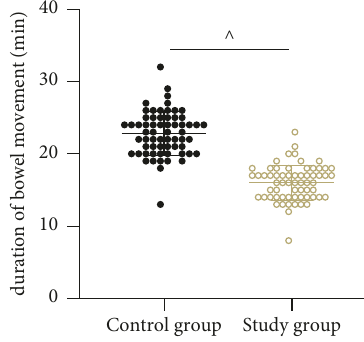
Figure 7: Comparison of care satisfaction scores within the two groups (scores). ^ represents a significant difference between the two groups.